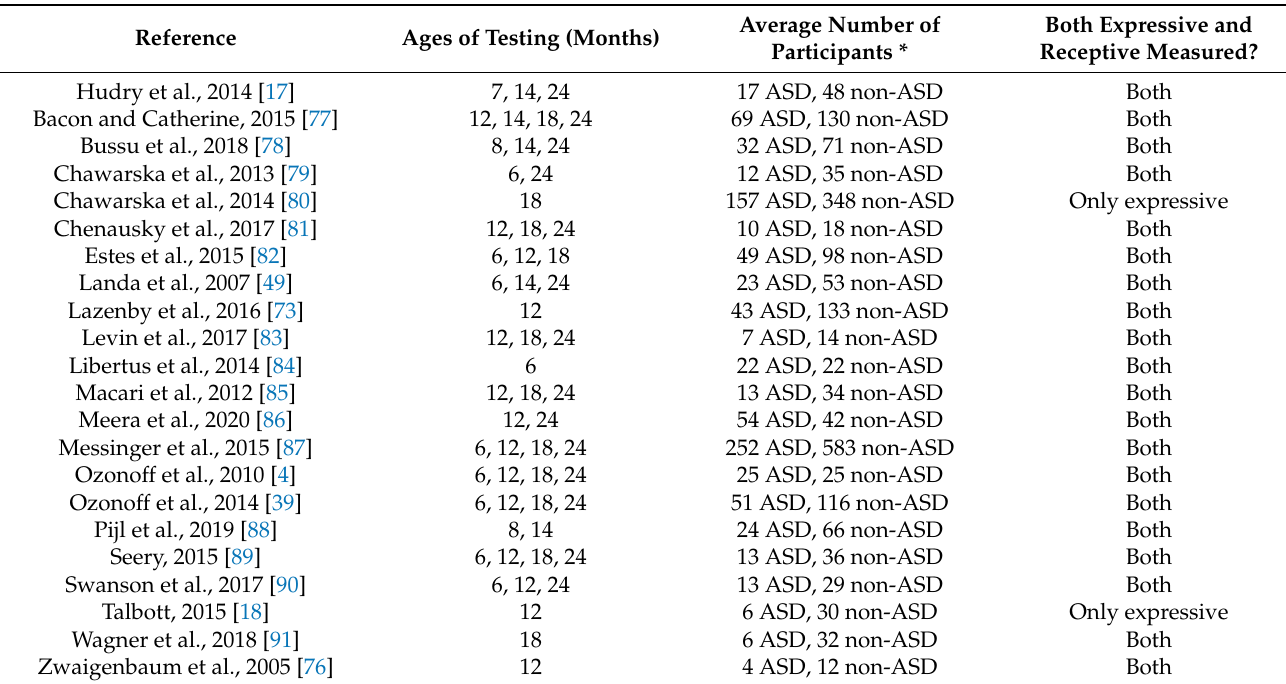
Table A4. Studies with clinical diagnosis on the Mullen Scales of Early